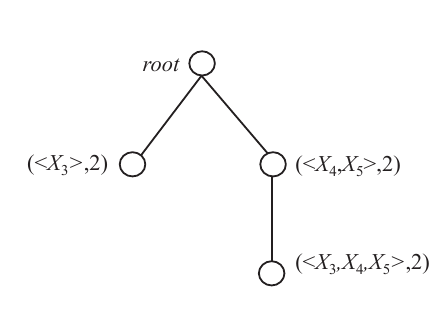
Fig. 1. The DRS-Tree of Example